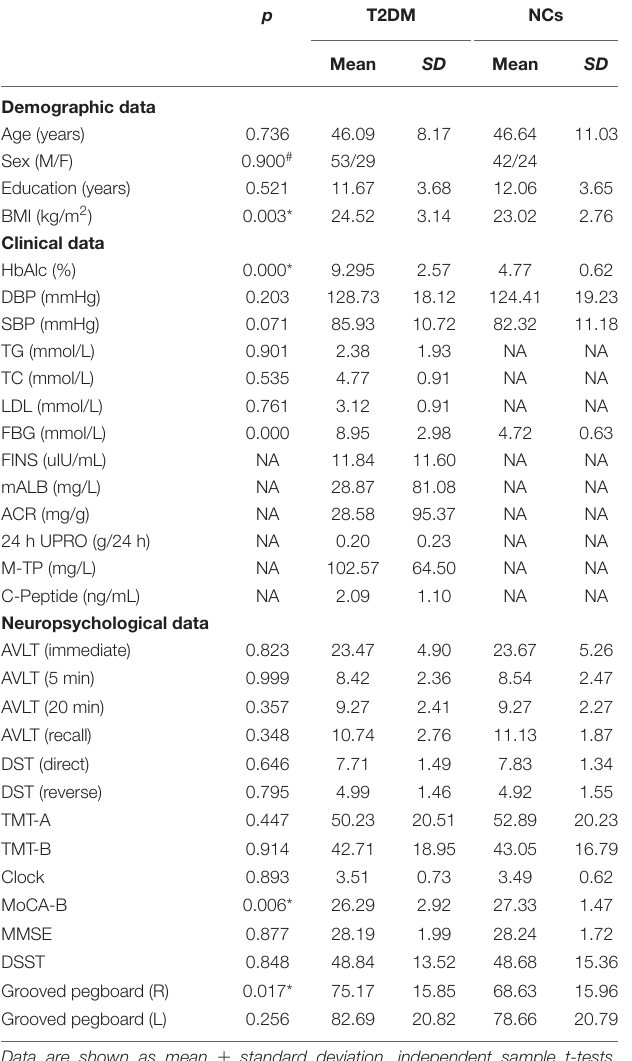
TABLE 1 | Clinical and neuropsychological results of patients with type 2 diabetes mellitus (T2DM) and normal controls (NCs). p T2DM NCs Mean